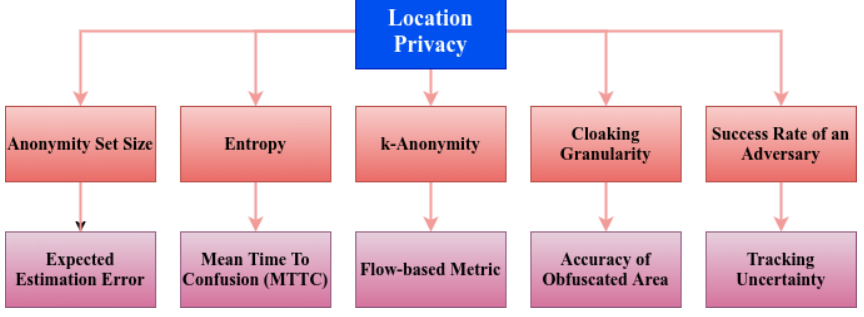
Figure 2. Location privacy assessment